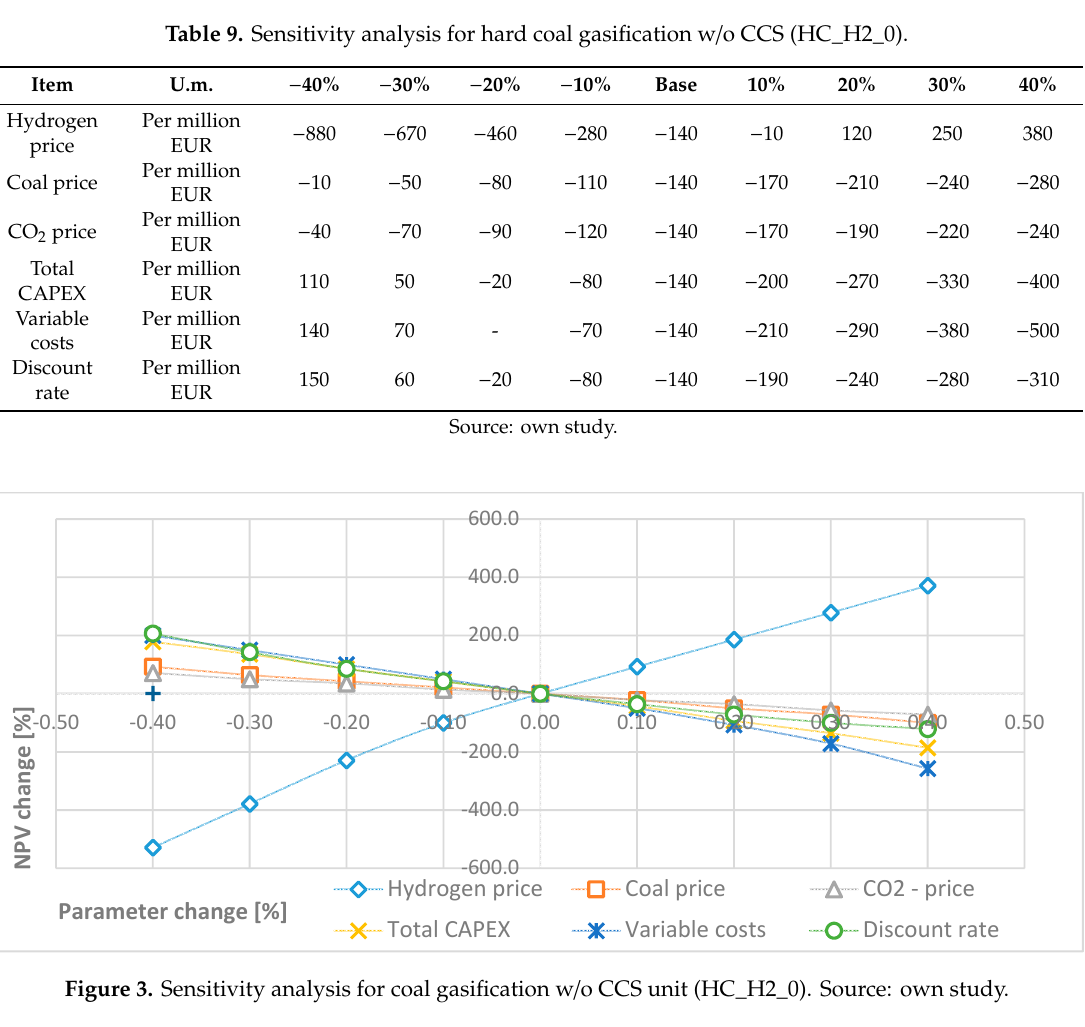
Table 9. Sensitivity analysis for hard coal gasification w / o CCS (HC_H2_0).